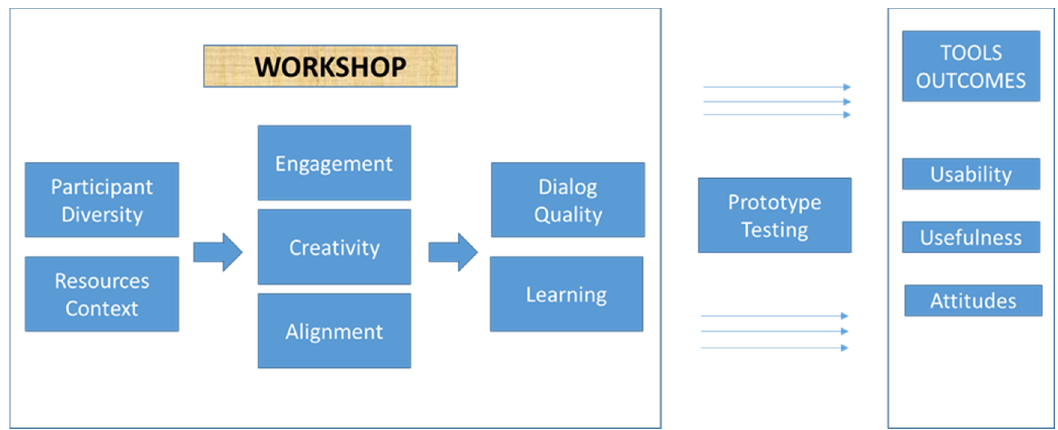
Figure 3. Workshop Framework Dimensions. Adapted from [53].